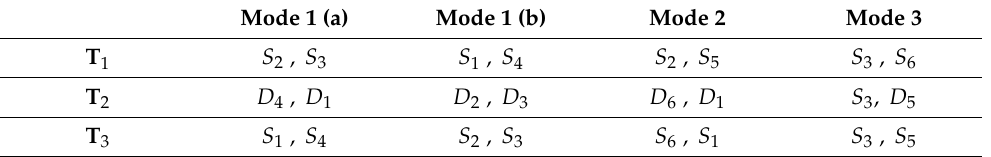
Table 4. Modes (1), (2), and (3) switching states.